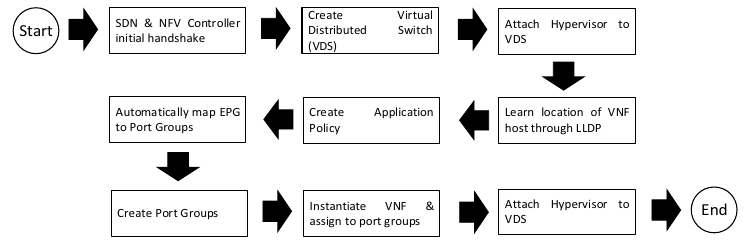
Figure 10. Integration